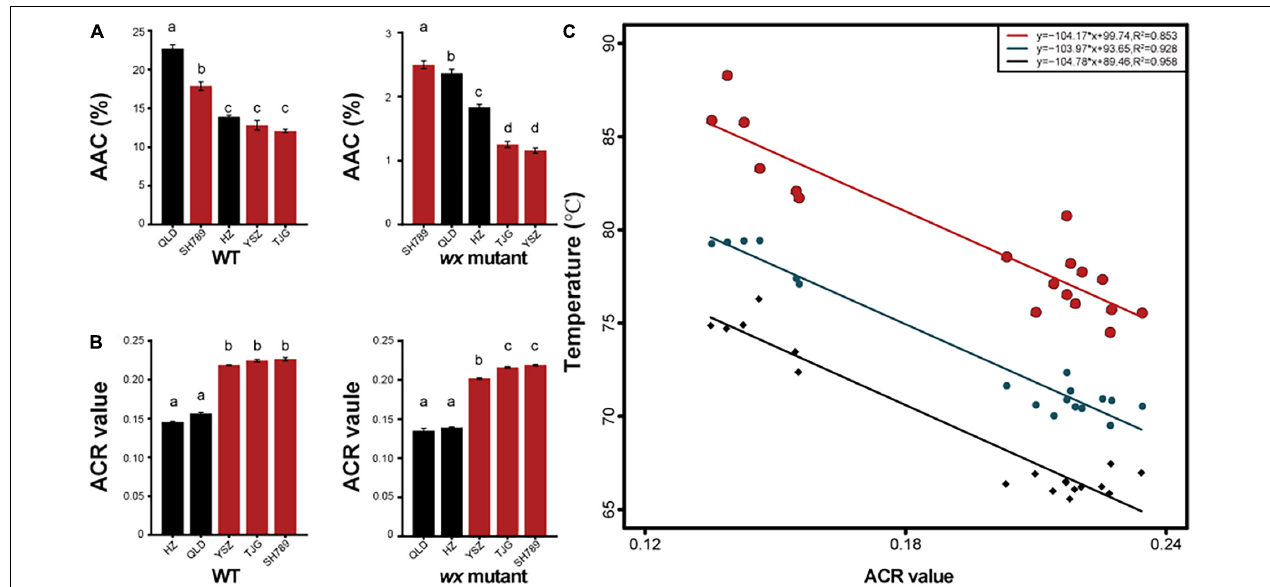
FIGURE 5 | The apparent amylose content (AAC) and amylopectin chain ratio (ACR) value of five wx mutants and their corresponding WTs (A) AAC of five wx mutants and their corresponding WTs. (B) ACR value of five wx mutants and their corresponding WTs. AAC and ACR value of WTs (left-hand bar graph) and wx mutants (middle bar graph). (C) Relationships between ACR value and gelatinization temperature; each point represents the ACR value of a variety of rice or waxy rice. Black points represent the onset temperature ( To ), bluish-black points represent the peak temperature ( Tp ), and red points represent the conclusion temperature ( Tc ). Error bars are mean ± SD ( n = 3). Values followed by different superscripts in the same column are significantly different ( P <